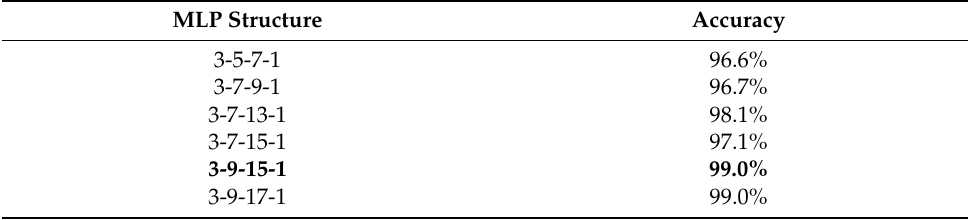
Table 3. The MLP classifier accuracy for different structures of the network.